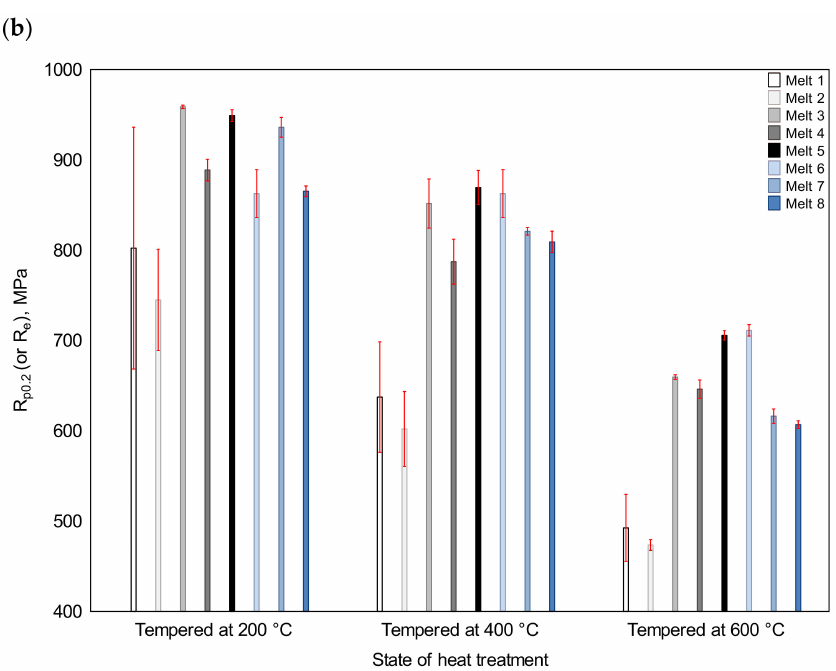
Figure 11. Hardness ( a ) and yield point ( b ) of the analyzed alloys after quenching and tempering at 200, 400 and 600 ◦ C.